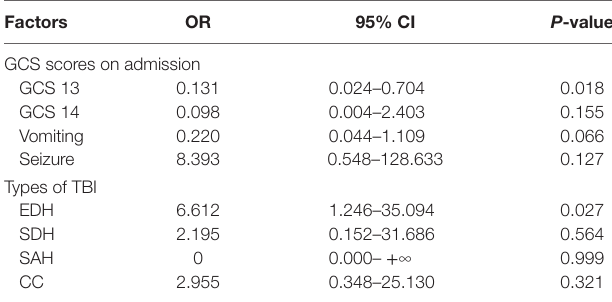
TaBle 3 | Multivariate logistic regression for risk factors of progressive hemorrhagic injury.